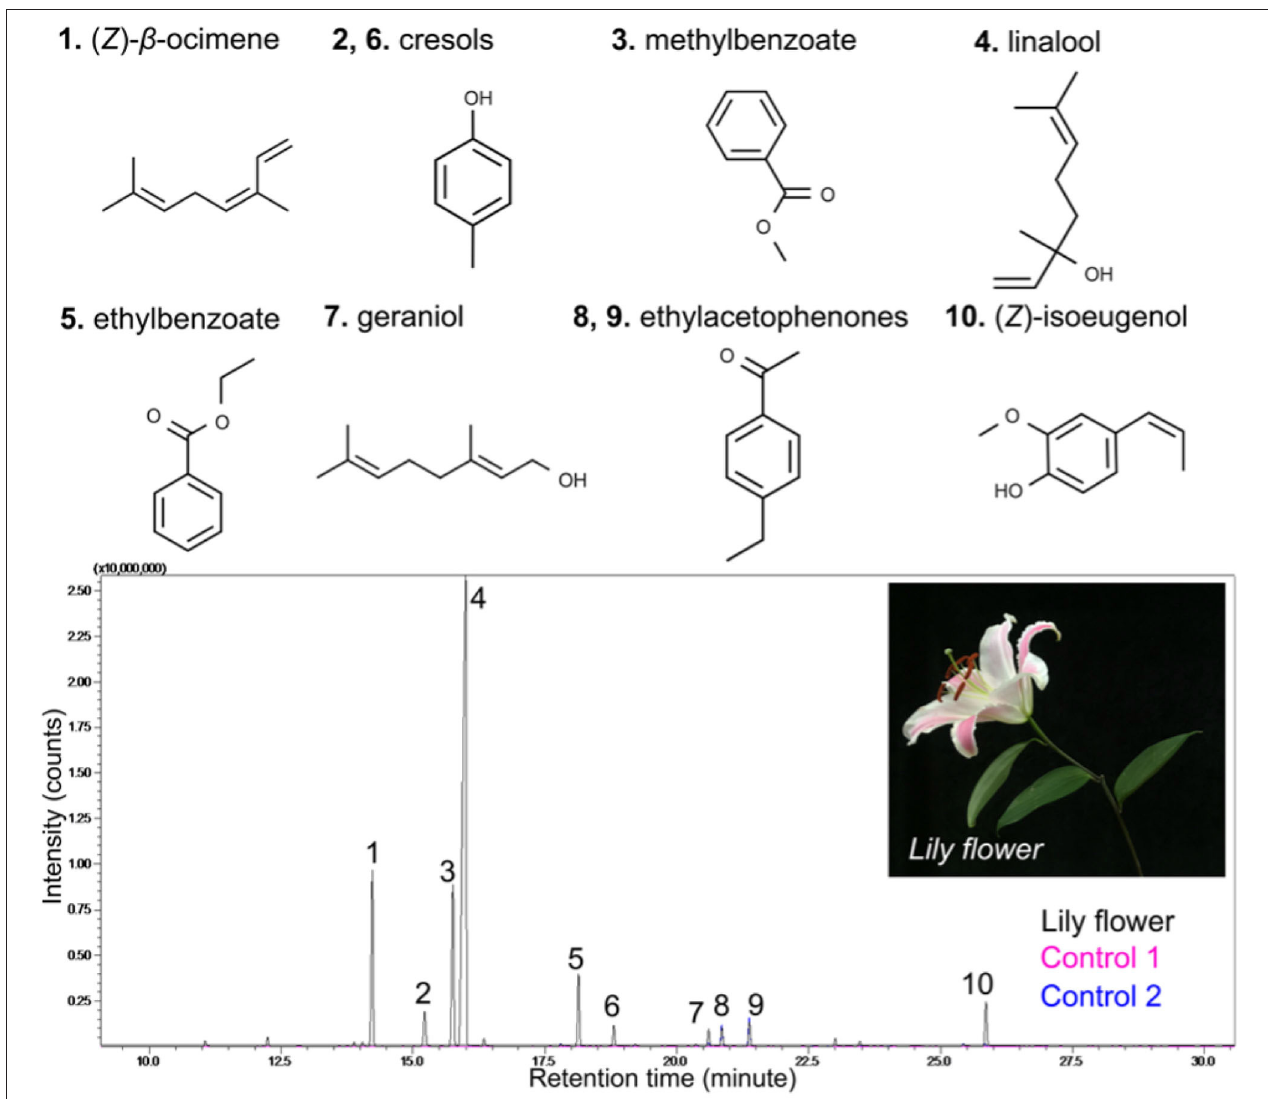
FIGURE 2 | Gas chromatograms of lily floral volatiles. Floral headspace volatiles were collected from one lily flower. The major peaks (compounds) were identified by comparing mass spectra with spectra of a NIST library. Labeled compounds are: (1) (Z)- β -ocimene, (2) cresol, (3) methylbenzoate, (4) linalool, (5) ethylbenzoate, (6) cresol, (7) geraniol, (8, 9) ethylacetophenones, and (Z)-isoeugenol. Control 1 and 2 show any ambient contaminants in the